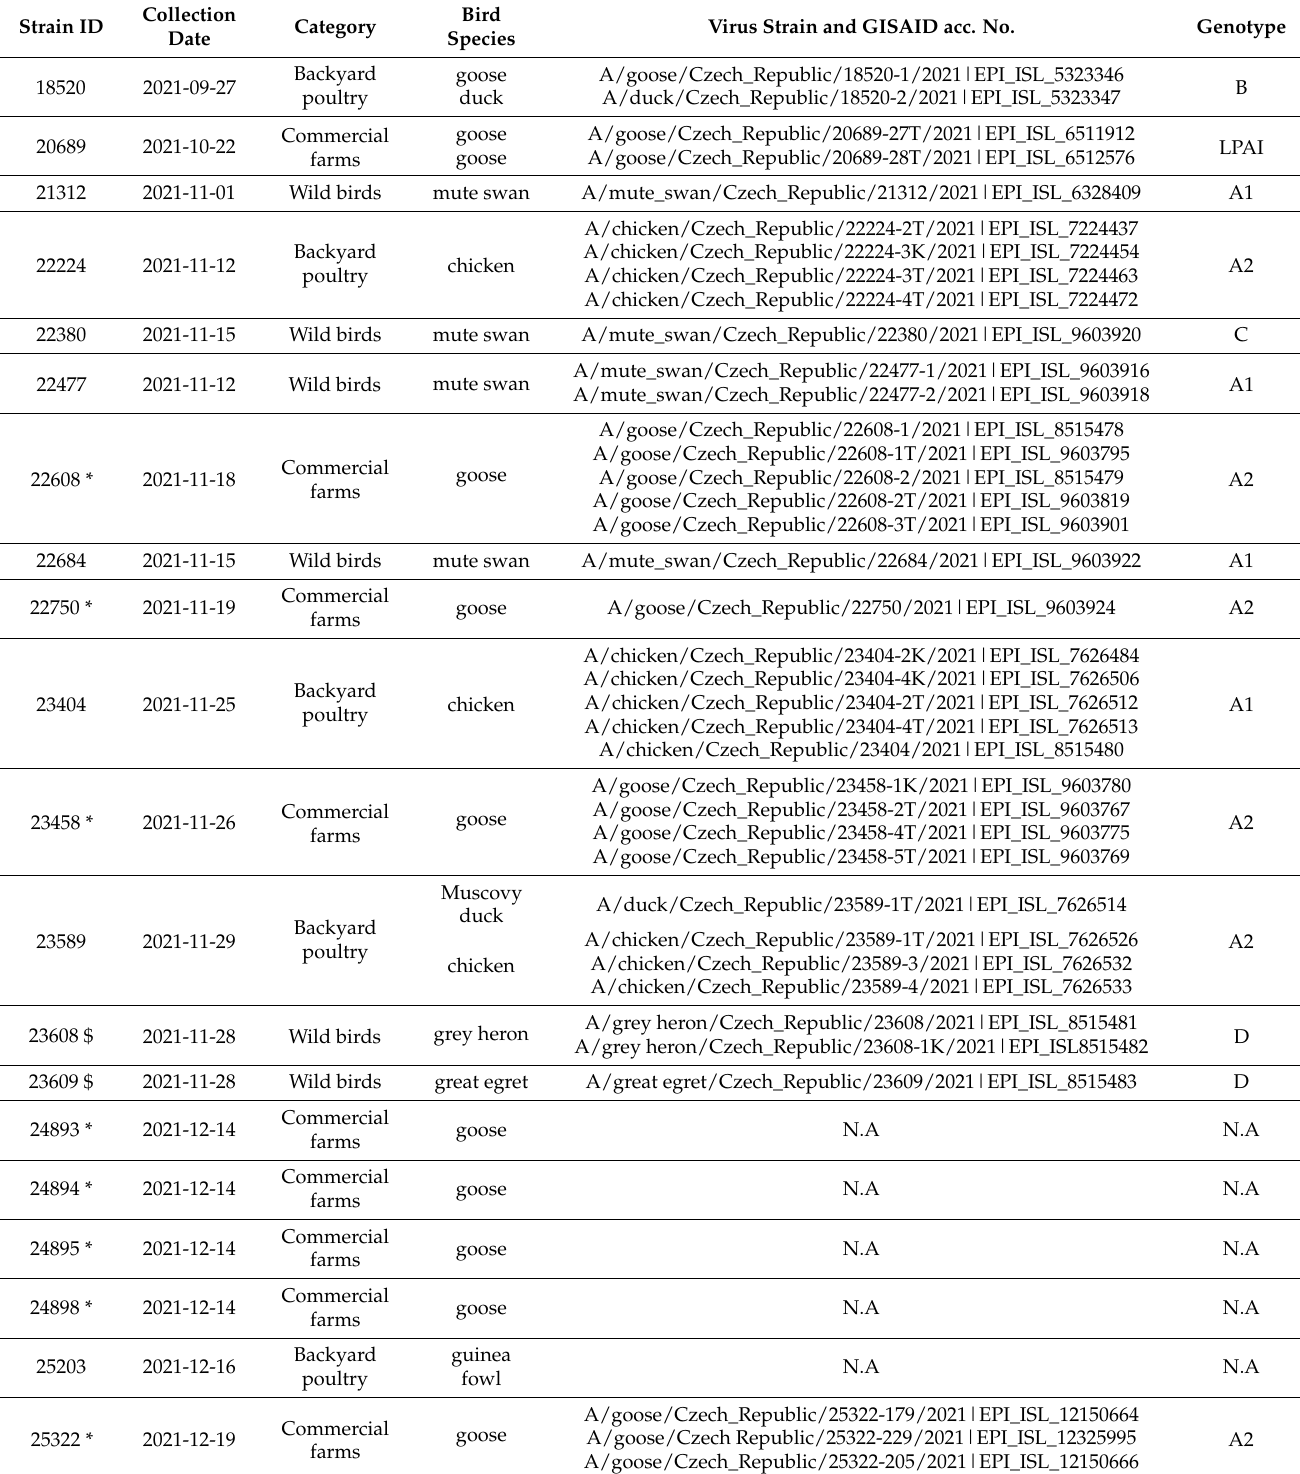
Table 1. The 2021/2022 H5N1 sampling events listed in chronological